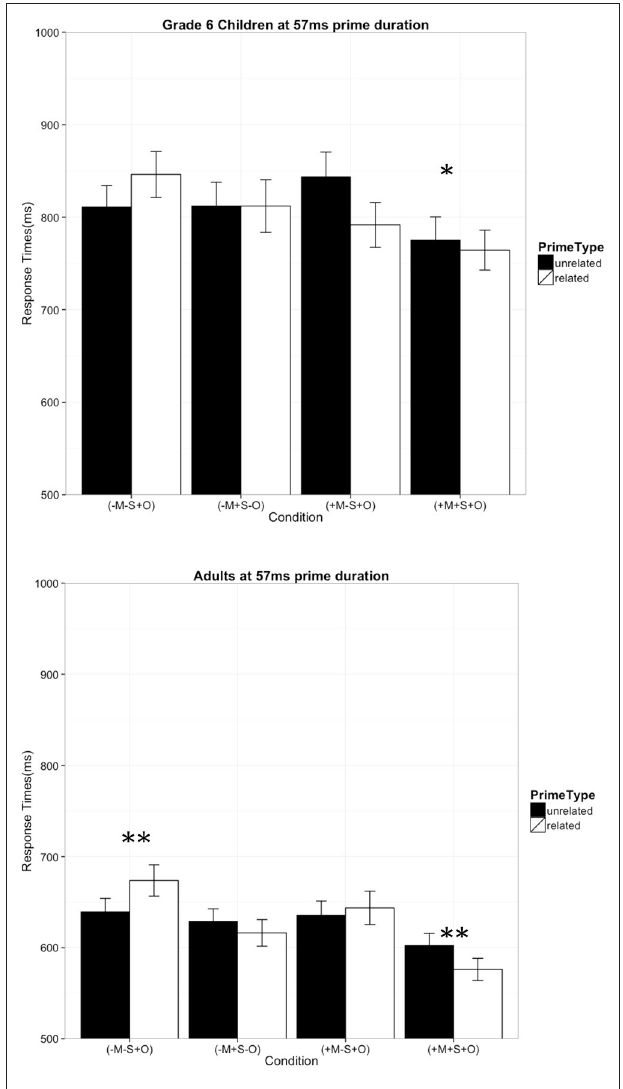
FIGURE 3 | Priming effects in reaction times in Experiment 3 (* p < 0.05, ** p < 0.01).